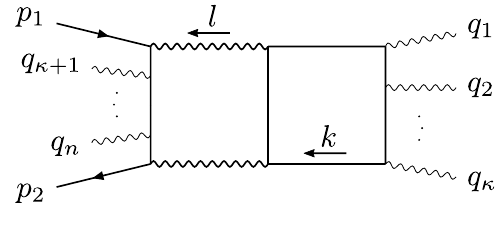
, κ > 0 two-loop amplitude coeffi- κ +2